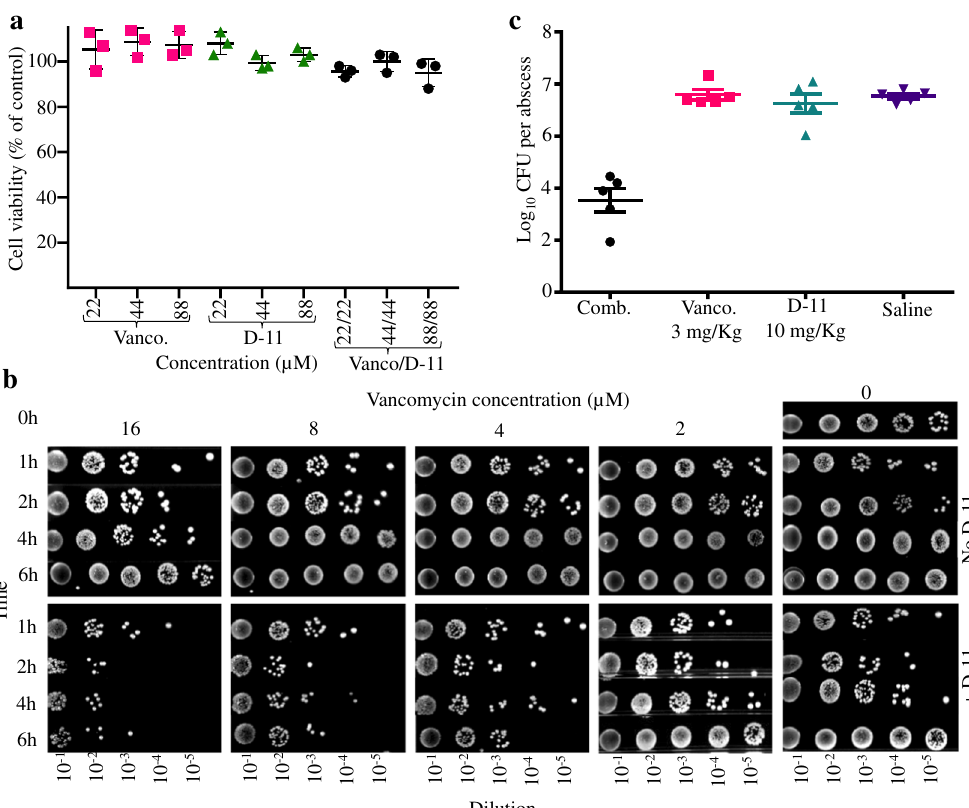
Fig. 3 Toxicity and activity ex vivo/in vivo of D-11 with or without vancomycin. a Effect on the cell viability for vancomycin (vanco.), D-11, and their combination against HEK-293 cells. b Ex vivo bacteremia model for vancomycin, D-11, and their combinations. 10 µ L of serial decimal dilutions of each one of the combinations of vancomycin (16, 8, 4, and 2 µ M) with/without D-11 (4 µ M) tested in blood were dropped. c In vivo ef fi cacy of vancomycin and D-11 alone and its combination (comb.) against P. aeruginosa PA14. Saline is the negative